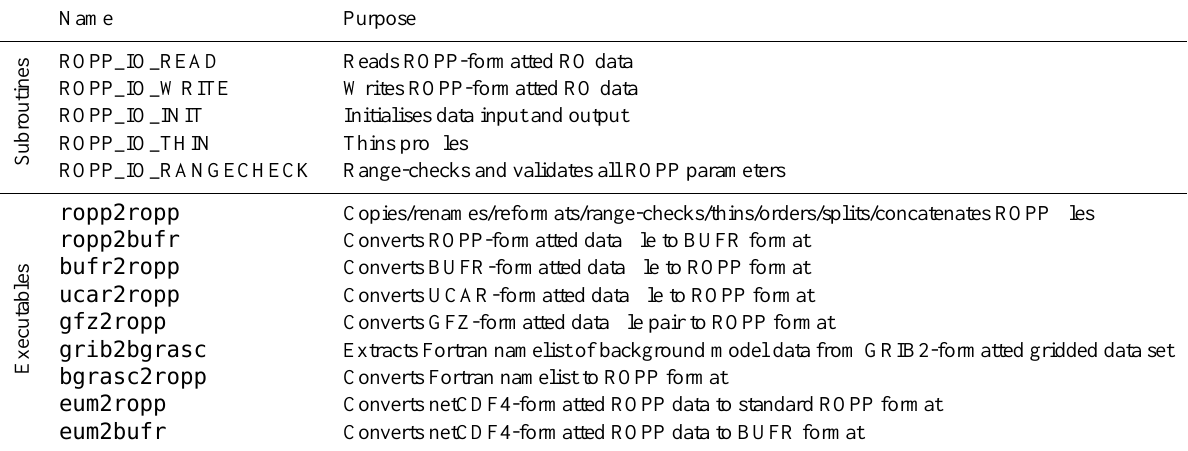
Table 3. Subroutines and standalone executables in the ROPP IO module.